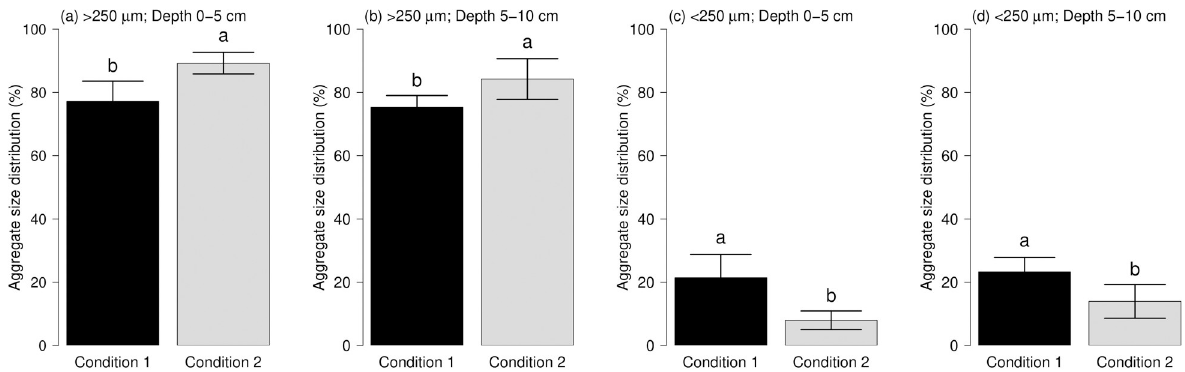
Fig 2. Distribution by the size of water-stables aggregates at two soil depths in lacustrine soil studied. Barplot (a) and (b) represent > 250 μ m aggregates at 0–5 and 5–10 cm, respectively. Correspondingly, barplot (c) and (d) represent < 250 μ m aggregates at 0–5 and 5–10 cm, respectively. Different letters indicate statistically significant differences at the 0.05 level by Tukey’s post-hoc test.